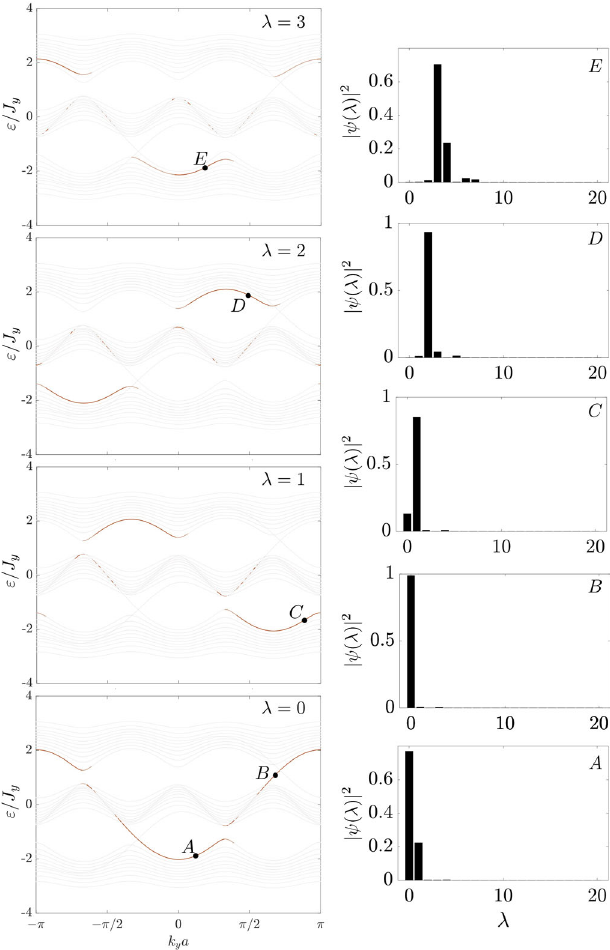
FIG. 11. Energy spectra as in Fig. 7(a), where we show only the parts of the spectra whose states are localized around λ ¼ 0 , 1, 2, 3, respectively. The amplitudes j ψ ð λ Þj 2 of the states indicated with a dot are also